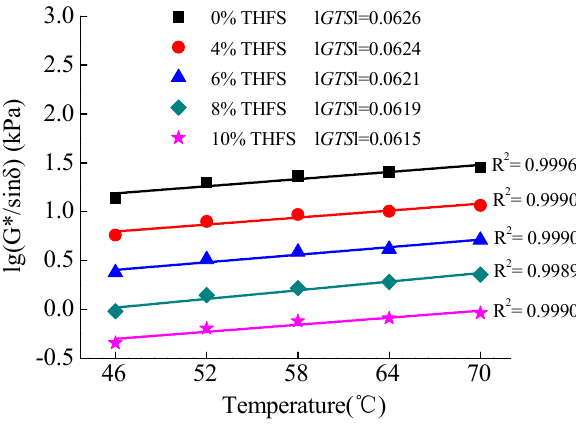
Figure 4. Relationships between lg(G*/sin δ ) of Asphalt Binder and Temperature.